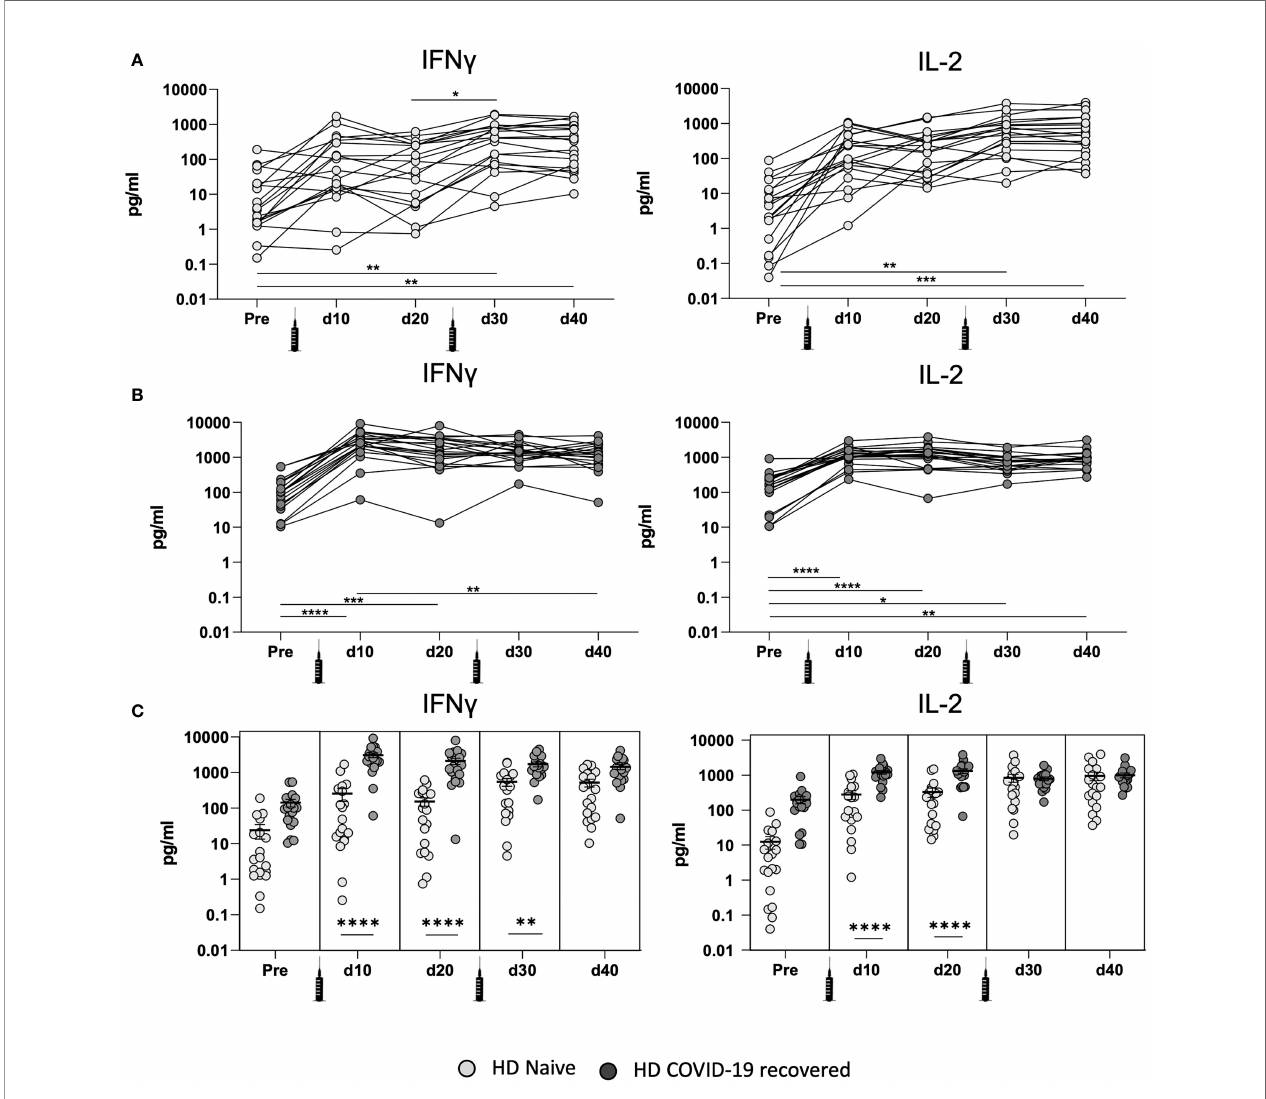
FIGURE 1 | Development of cellular immunity after mRNA-1273 vaccination in COVID-19 recovered and naïve HD patients. (A) Quanti fi cation of IFN- ɣ and IL-2 production in the whole blood by naive HD patient cells at different time points: before vaccination (pre), after the fi rst (d10 and d20) and second (d30 and d40) mRNA vaccine dose. (B) Quanti fi cation of IFN- ɣ and IL-2 production in the whole blood by COVID-19 recovered HD patient cells at different time points. (C) Comparison of IFN- ɣ and IL-2 production between naïve and COVID-19 recovered HD patients. All samples were analyzed after overnight stimulation of whole blood with SARS-CoV-2 peptide pools. IFN- ɣ and IL-2 levels were determined using ELLA single plex cartridges (n= 39; 19 naïve HD patients and 20 COVID-19 recovered HD patients). Values higher than 32.7 pg/ml and 36.8 pg/ml were considered positive for IL-2 in naïve HV and HD patients, respectively. Values higher than 9.0 pg/ml and 27.6 pg/ml were considered positive for IFN- ɣ in naïve HV and HD patients. * <0.05, ** <0.005, *** <0.0005, ****